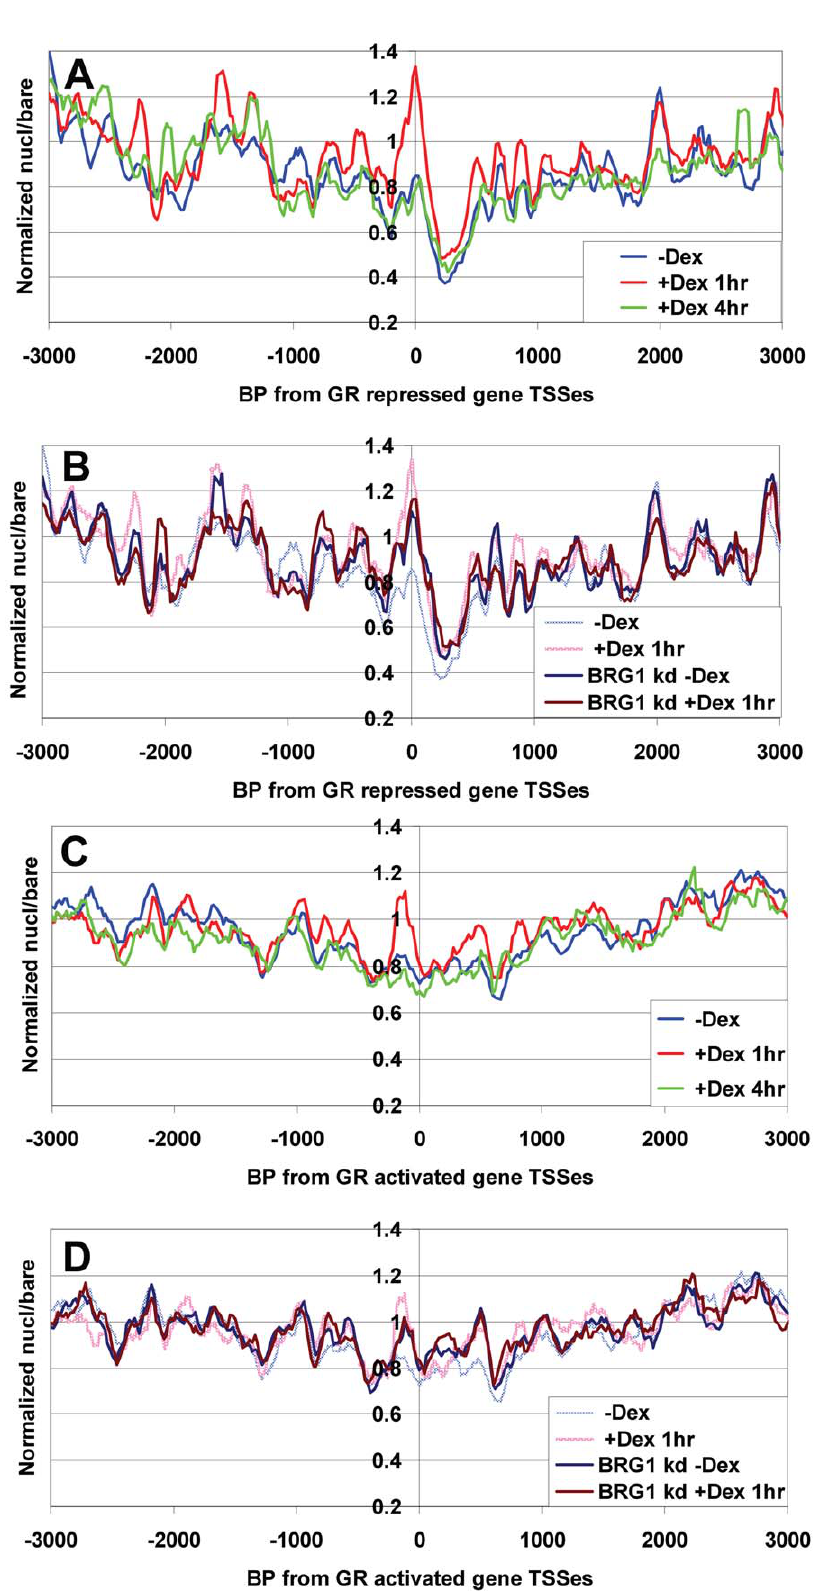
Figure 3. Average nucleosome occupancy rises transiently + Dex surrounding TSSes of GR activated and GR repressed genes. ( A ) & ( B ) Average nucleosome density relative to the transcription start sites of the four Dex repressed genes on the array: GEM , PLK2 , POMC & MYC . ( C ) & ( D ) Average nucleosome density vs. TSSes for nine of the GR-activated endogenous genes on the array: HSD11B2 , TSC22D3 , PCK1 , ZBTB16 , SDPR , SGK1 , SLC19A2 , CYP3A4 & SRGN. MMTV was excluded from this analysis to avoid contributions of non- MMTV vector and luciferase sequences upstream of